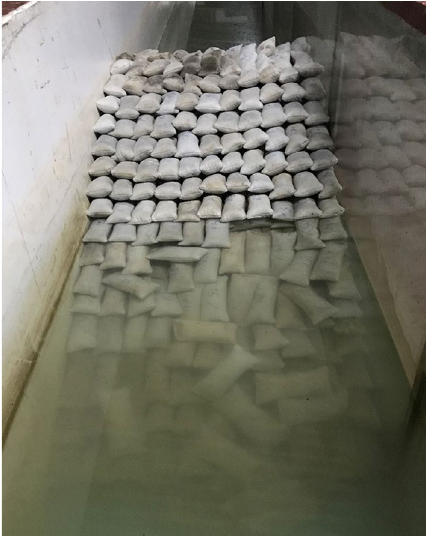
Figure 16. Image showing detached GSC units from the outer layer of breakwater model.